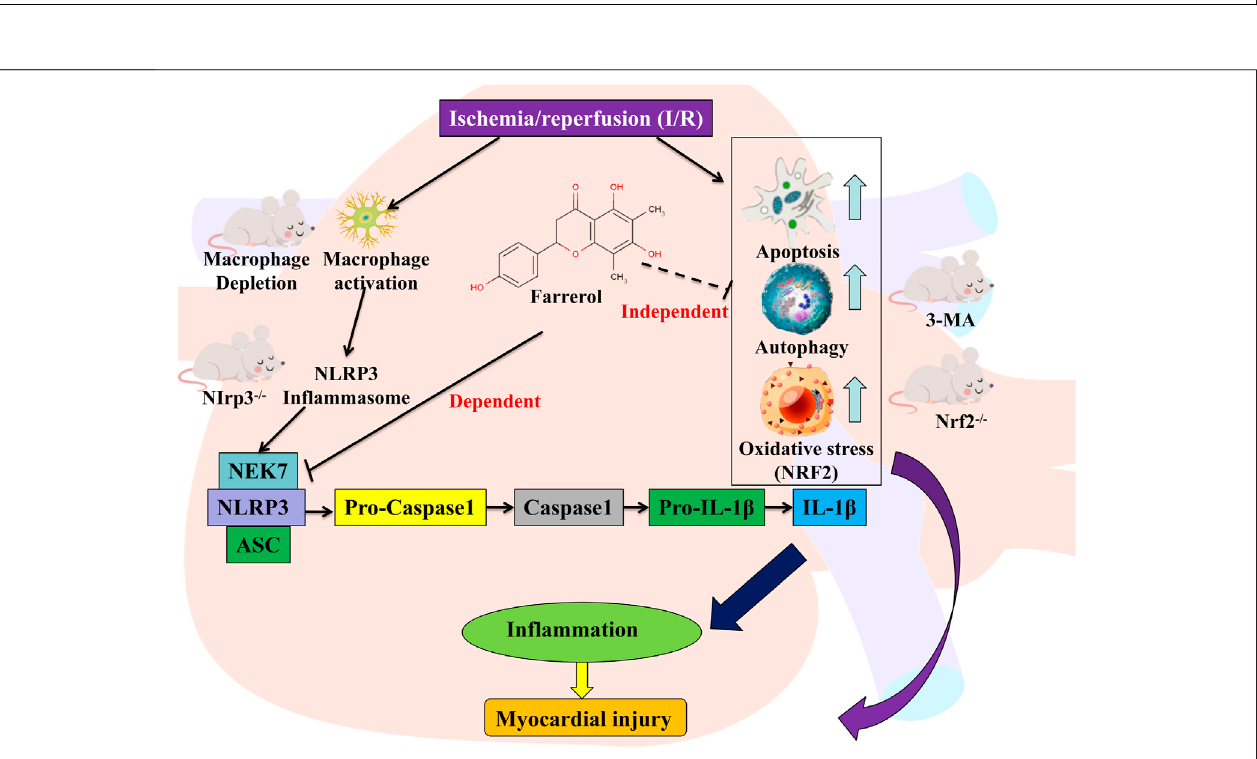
FIGURE 11 | Graphic abstract for major fi ndings and proposed mechanism. FA inhibits the NEK7-NLRP3 interaction, thereby inhibiting NLRP3 in fl ammasome assemblyandactivation,resultinginaneffectiveinhibitiontoalleviatemyocardialischemia/reperfusioninjury.SchematicrepresentationofthemechanismofactionofFA.